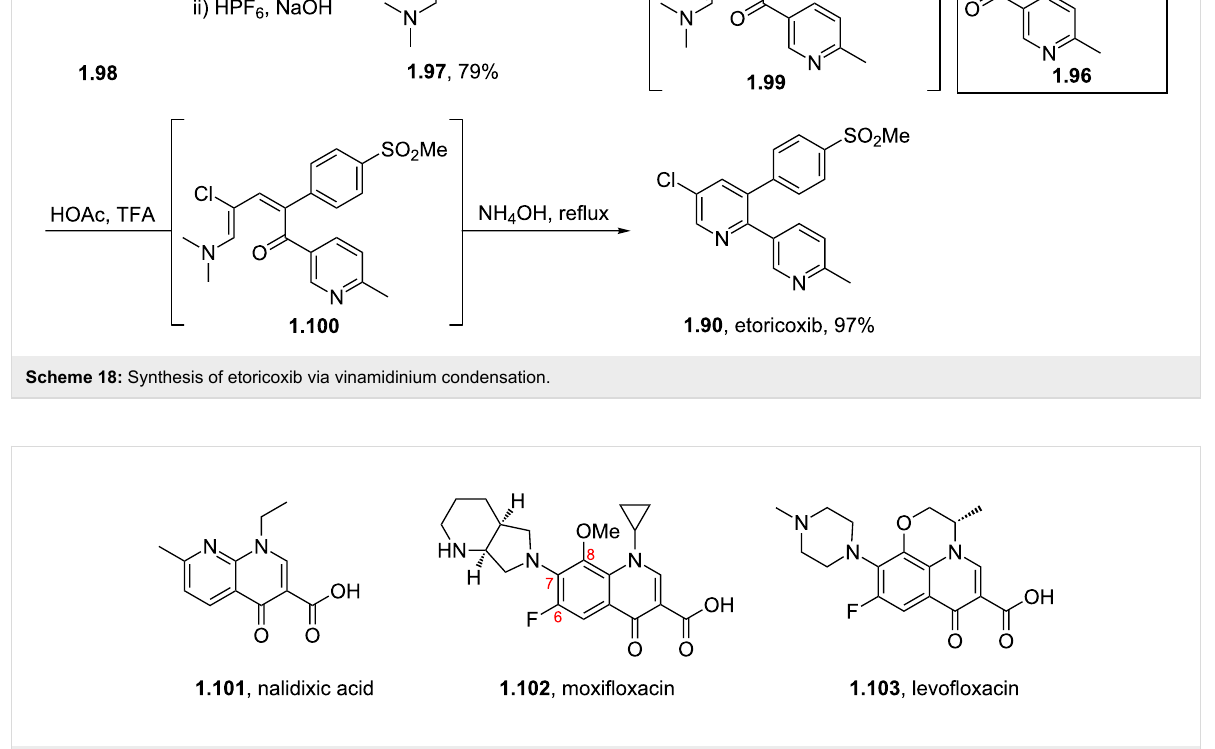
Figure 2: Structures of nalidixic acid, levofloxacin and moxifloxacin.